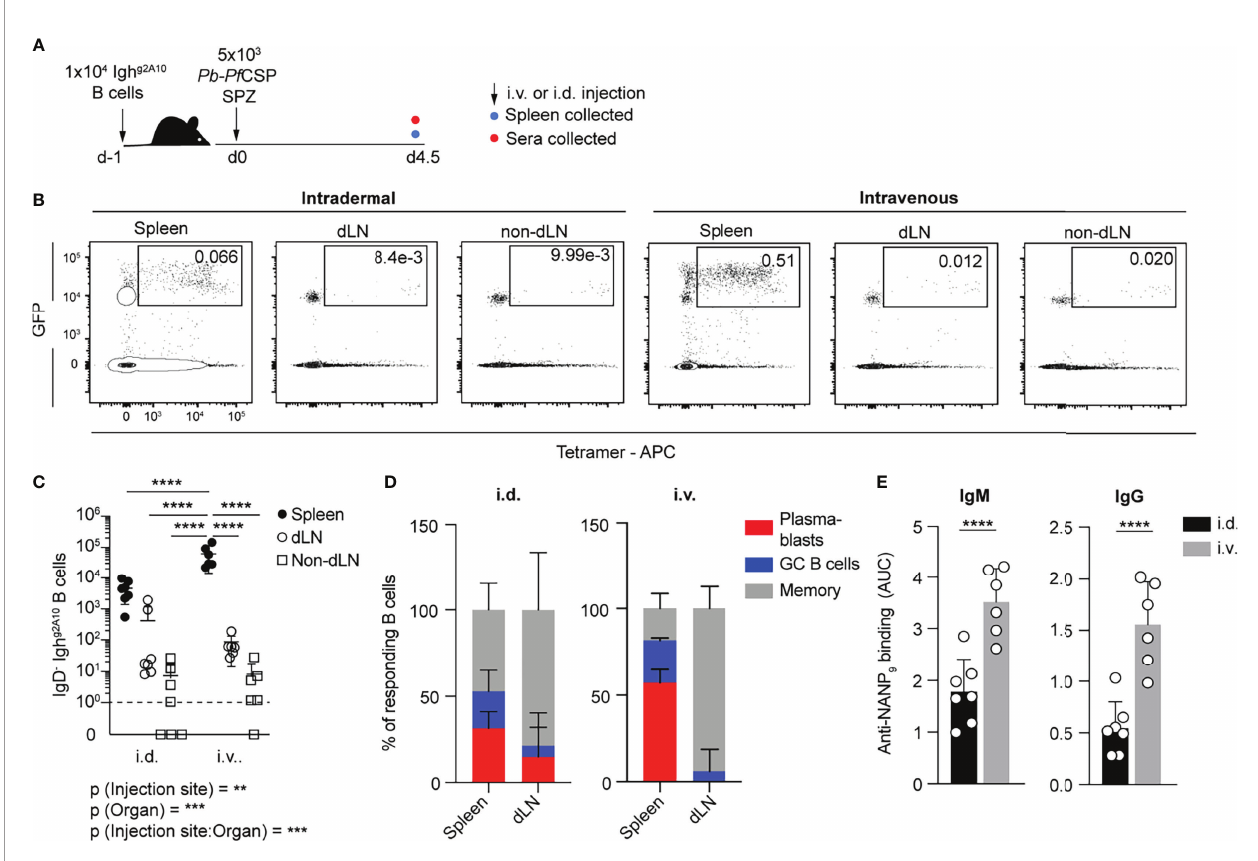
FIGURE 1 | Splenic plasmablasts dominate the early response, regardless of immunization route. C57BL/6 mice received 1x10 4 Igh g2A10 cells prior to intradermal (i.d.) or intravenous (i.v.) immunization with 5x10 3 Pb-Pf CSP SPZ, 4.5 days later spleen and blood were taken for analysis. (A) Schematic of experiment. (B) Representative plots showing the proportion of total Igh g2A10 B cells recovered in spleen, draining lymph nodes (dLN) and non-draining lymph nodes (non-dLN) on day 4.5 post-immunization. Total Igh g2A10 B cells pre-gated on singlets, lymphocytes, Dump-negative and B cells [CD19 + ± CD138 + ]. (C) Quanti fi cation of the IgD- Igh g2A10 B cells recovered from tissues day 4.5 post-immunization. (D) Day 4.5 B cell subsets as a proportion of total IgD- Igh g2A10 cells. (E) Serum titres of anti- Pf CSP antibodies quanti fi ed by ELISA and presented as area under the curve (AUC). Data are pooled from two similar experiments, with 3-4 mice per experimental group. Analyses were performed using linear mixed models, with injection site and organ set as fi xed experiment effects and the different experiments blocked to account for random effects. For (C) the overall p-value for each fi xed effect and their interaction is shown under the graph and the pairwise values derived from post tests are indicated on the graph itself. Abbreviations for p values are: p < 0.01 = **; p < 0.001 = ***; p < 0.0001 =